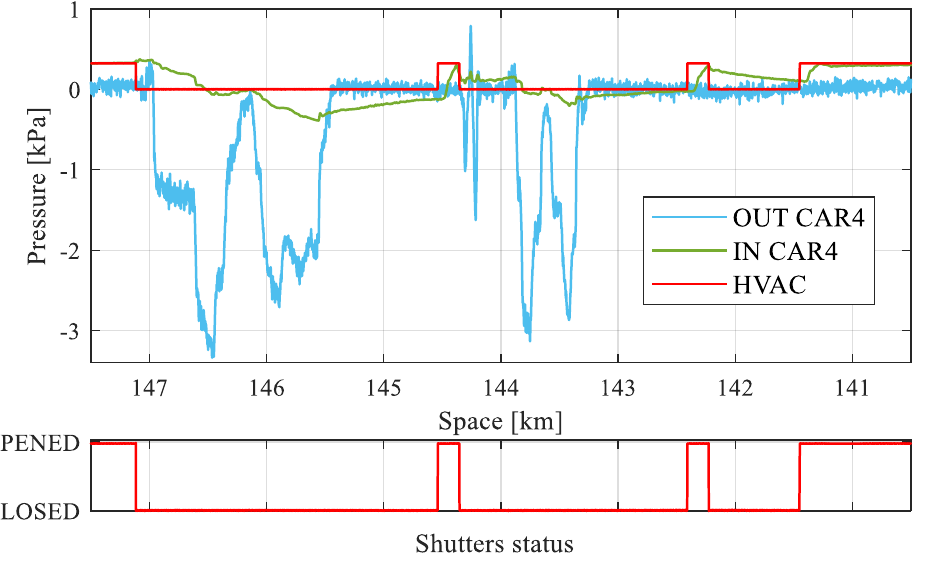
Figure 17. Example of the behavior of the HVAC shutters of the sealed train and corresponding pressure evolution.